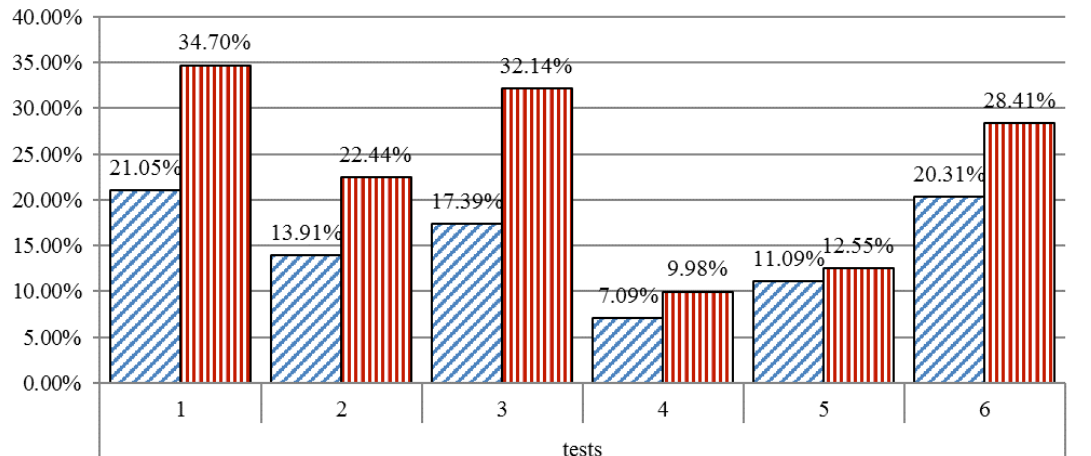
Fig.2 Growth of indicators of physical qualities development in percent among control (CG) and experimental (EG)